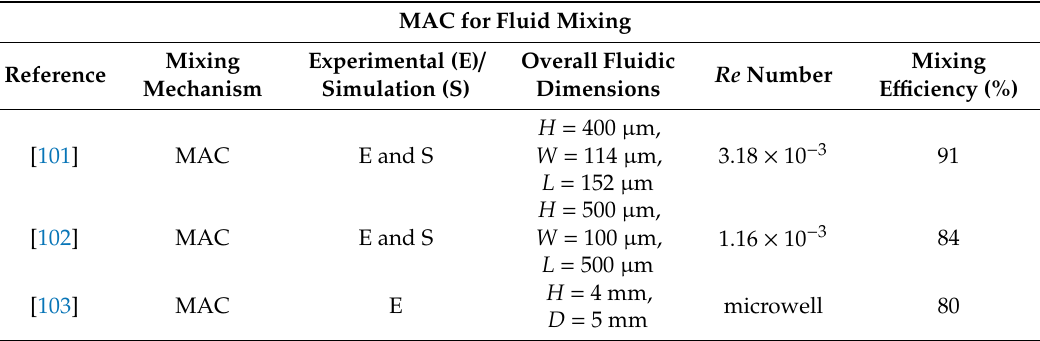
Table 2. Magnetically actuated cilia (MAC) examples of Re ≤ 1 over the past few years. MAC for Fluid